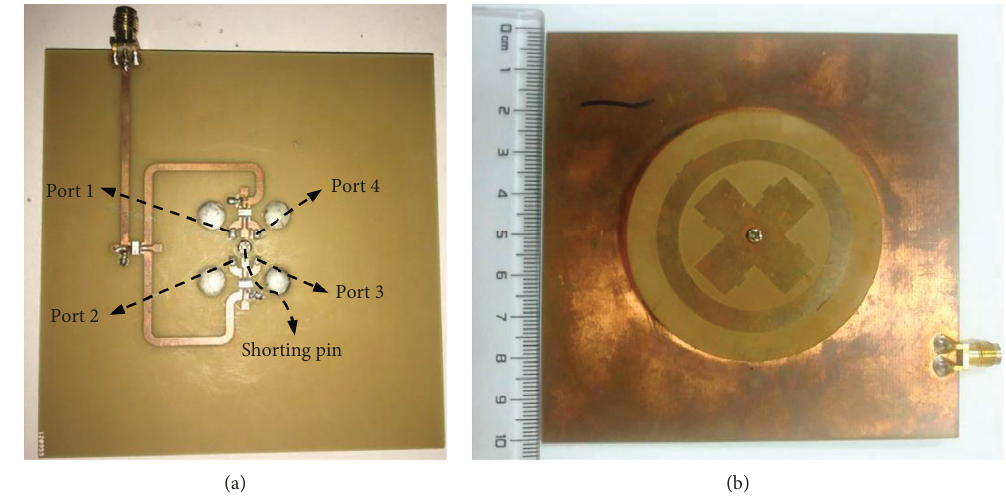
Figure 6: Photograph of the fabricated prototype